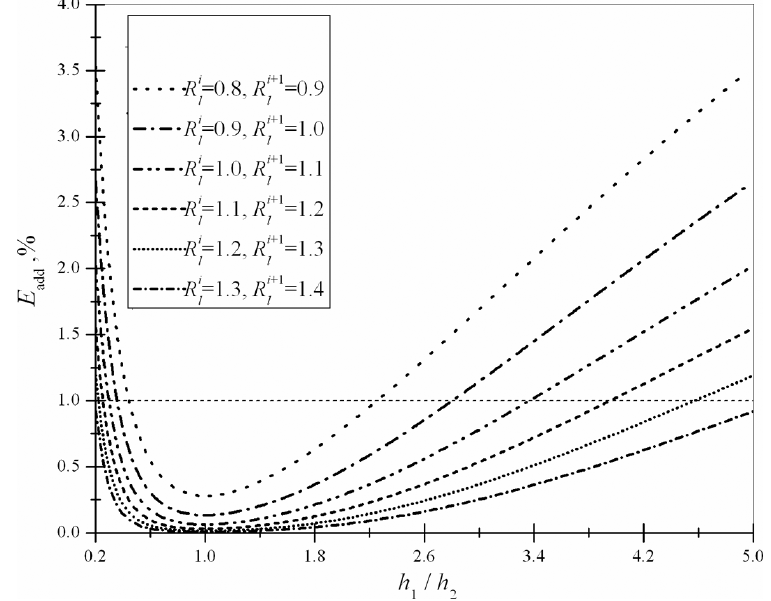
Fig. 4. Effect of tank width on added mass of a partially submerged